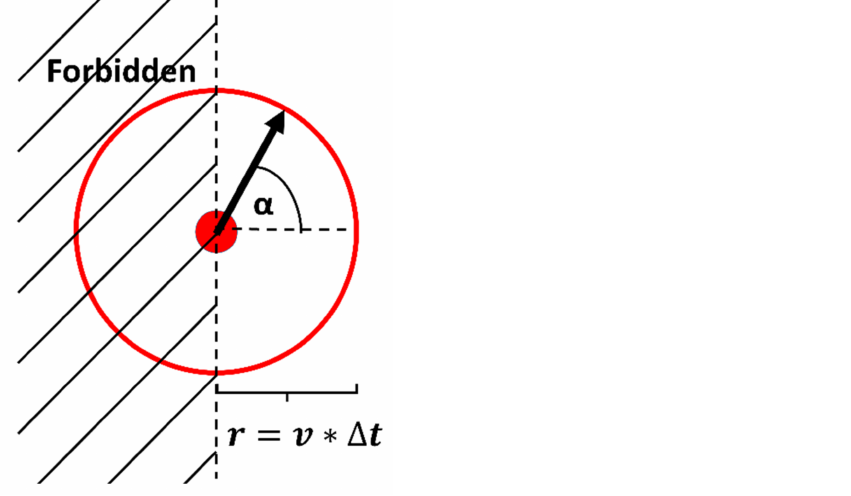
Figure A1. Illustration of the simulation model. The red dot corresponds to a cell moving at a constant speed v, in the direction determined by the angle α . Note that movements to the left, representing the cell cluster, are